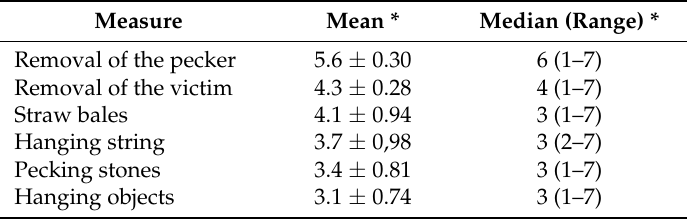
Table 5. The importance of preventive and intervention measures for pecking-related problems in laying hens, estimated by Finnish egg